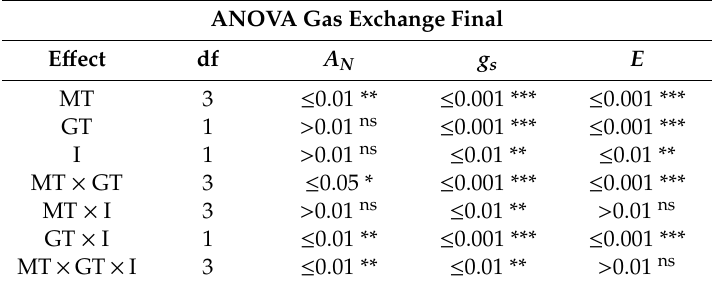
Table 5. ANOVA for the e ff ect of di ff erent maturation temperatures (MT), greenhouse temperature (GT), and irrigation or no irrigation conditions (I) in the instantaneous net photosynthesis ( A N , µ mol CO 2 m − 2 s − 1 ), stomatal conductance ( g s , mmol H 2 O m − 2 s − 1 ), and instant transpiration (E, mmol H 2 O m − 2 s − 1 ) in plants of Pinus radiata